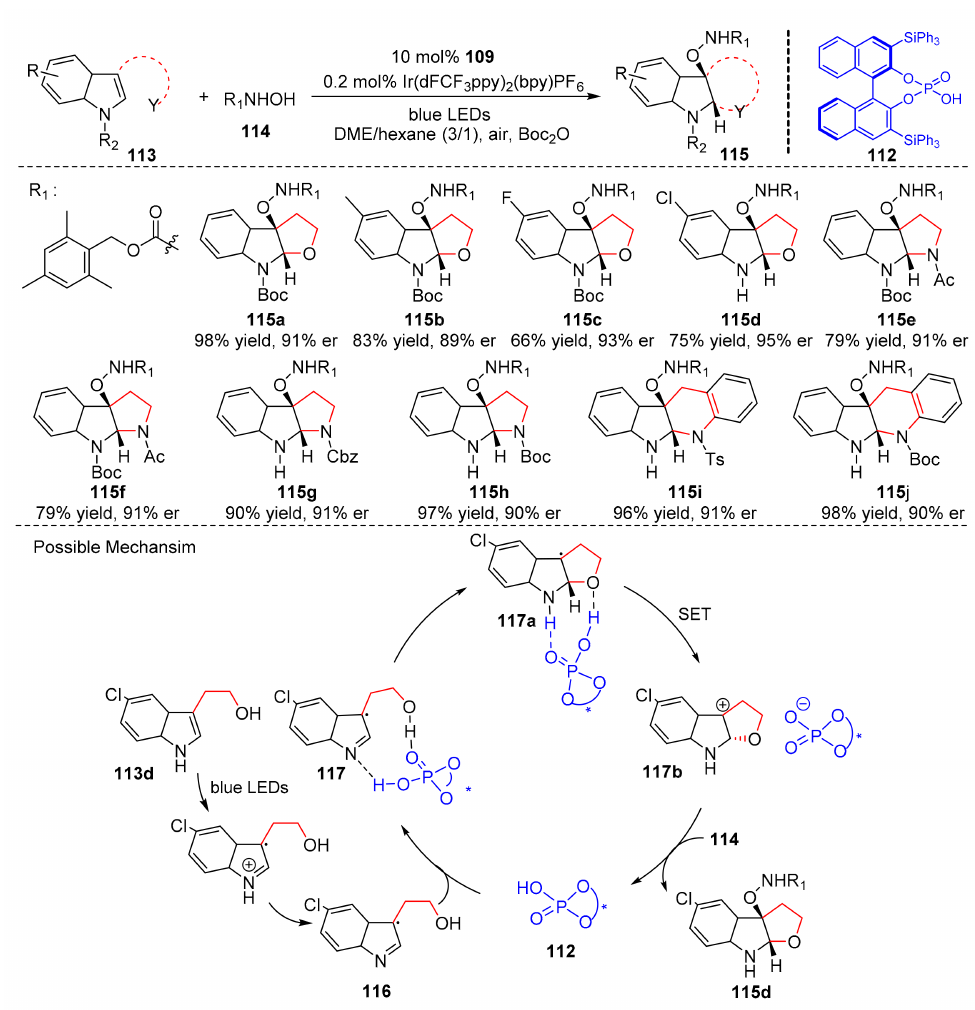
Scheme 25. Asymmetric dearomatization of substituted indolines and